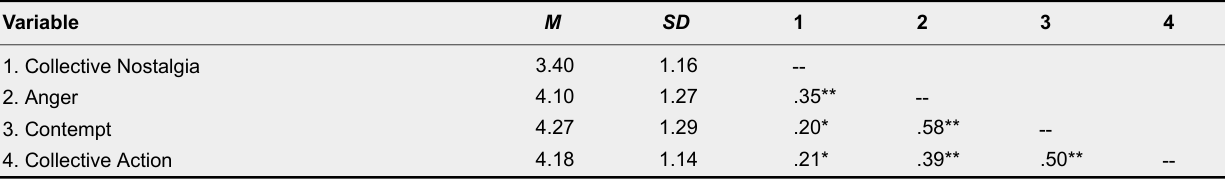
Zero-Order Correlations Among Collective Nostalgia, Outgroup-Directed Anger, Outgroup-Directed Contempt, and Ingroup-Favoring Collective